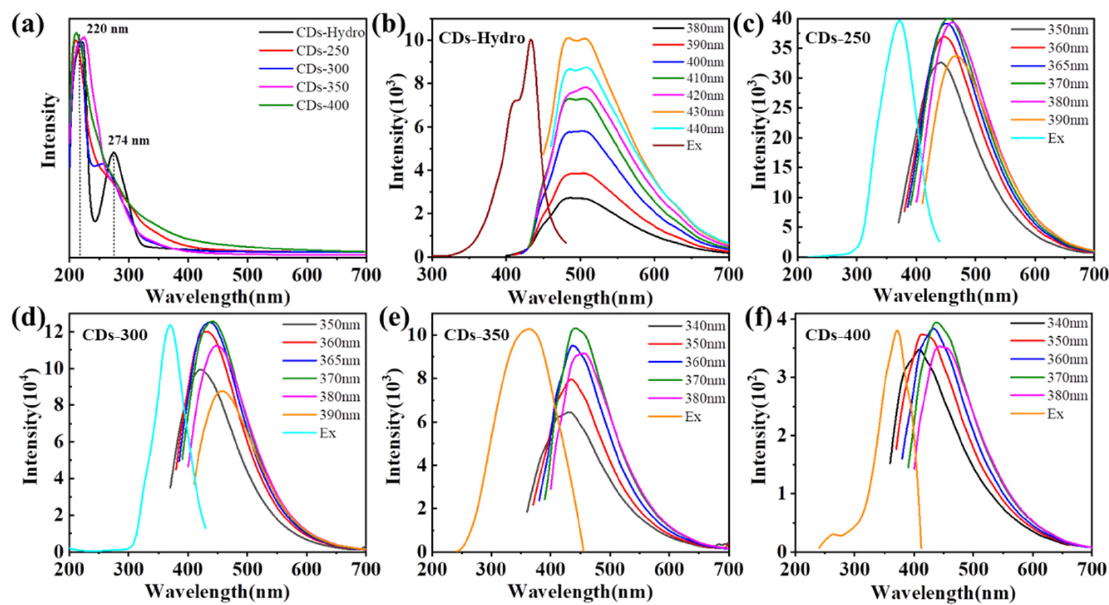
Figure 3. ( a ) UV/vis absorption spectra of CDs based on TA in ethanol solution. ( b ) PL emission spectra and PL excitation of CDs-Hydro in ethanol solution. ( c – f ) PL emission spectra and PL excitation of CDs-250 to CDs-400 in ethanol solution.